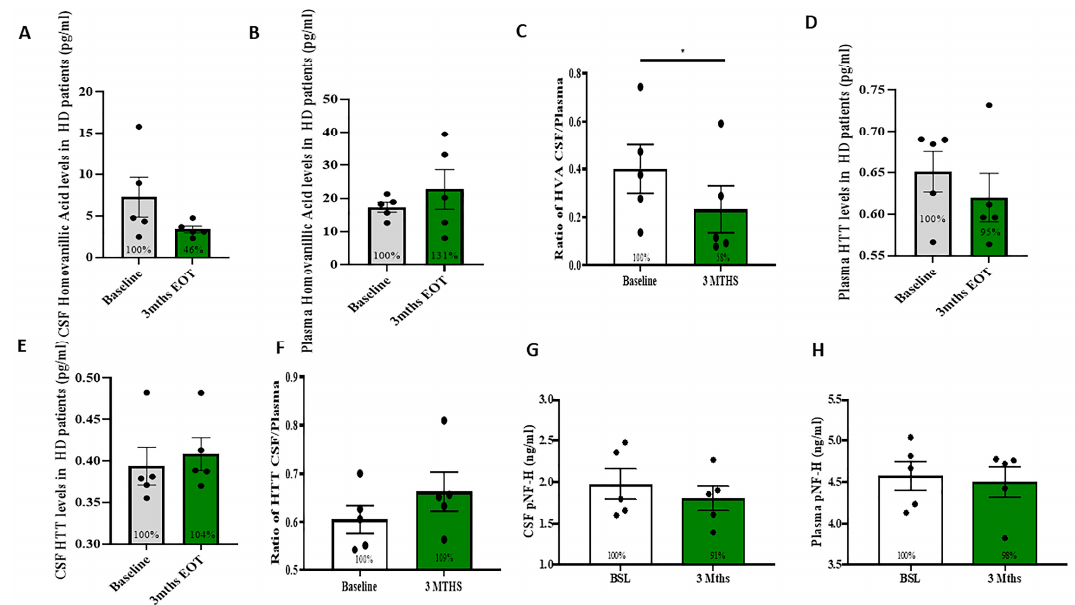
Figure 1. Measurement of potential biomarkers at baseline and 3 months following nilotinib treatment. ELISA levels of HVA in the ( A ) CSF and ( B ) plasma and ( C ) ratio of CSF/plasma HVA in HD patients. ELISA levels of HTT in the ( D ) plasma and ( E ) CSF and ( F ) ratio of CSF/plasma HTT in HD patients. ELISA levels of phosphorylated neurofilaments in the ( G ) CSF and ( H ) plasma in HD patients. n = 5, * designates p <